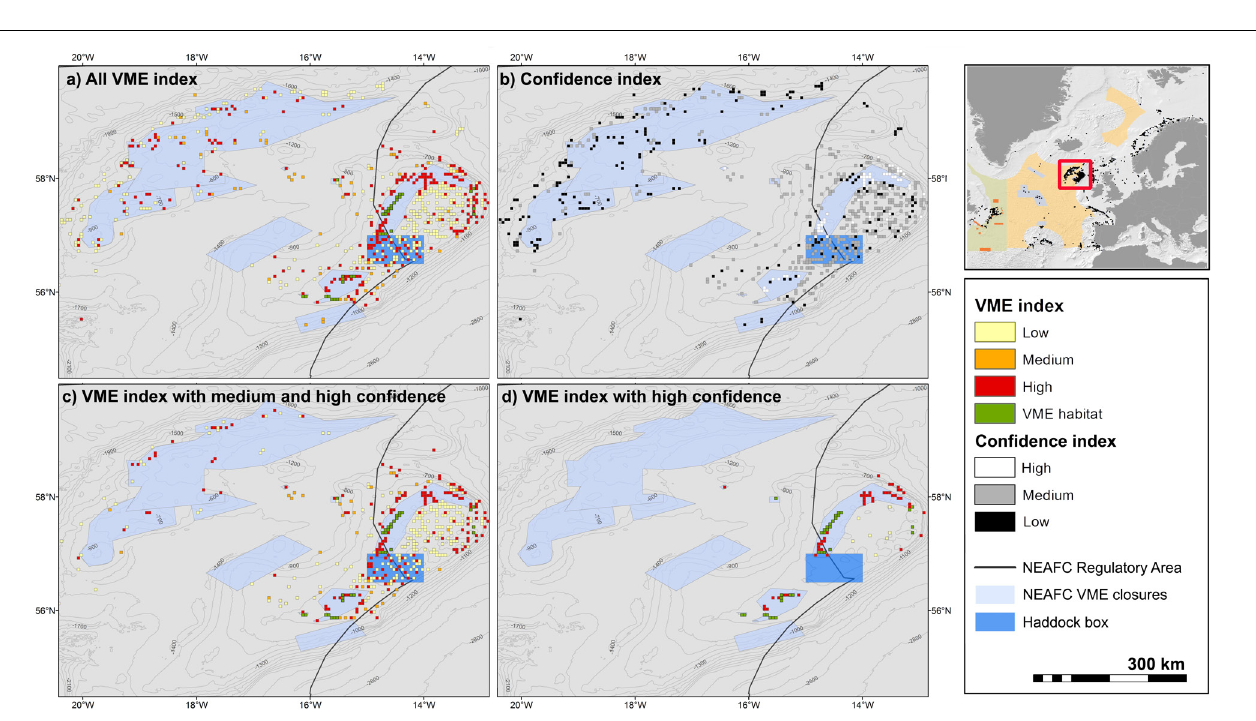
FIGURE 4 | Resulting distribution of the VME index (left) and the confidence index (right) when applied to the ICES VME database, including certain VME habitats (VME index of 5 and confidence index of 1; n = 225). Each value represents one grid cell of approximately 0.05 degrees by 0.05 degrees.